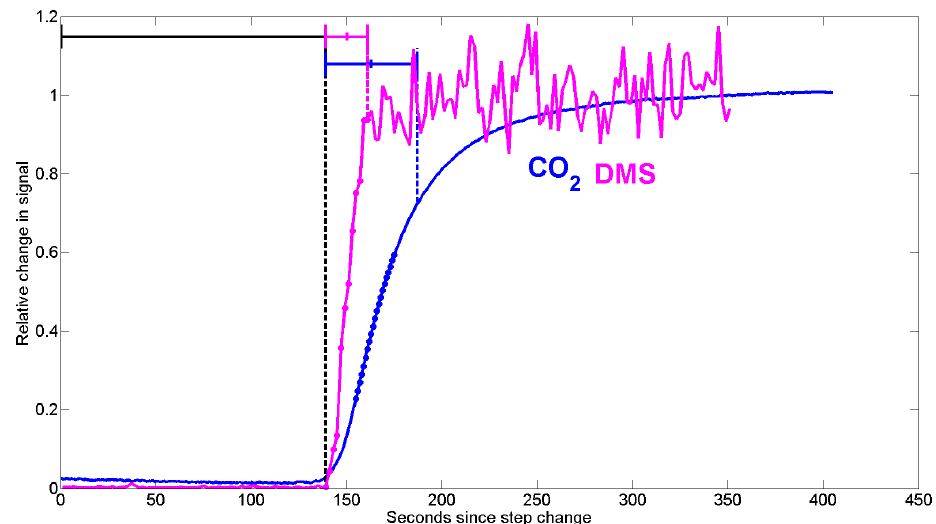
Figure 4. Instrument responses to step changes in seawater CO 2 (blue) and DMS (magenta). Step changes from 350 to 400µatm for CO 2 and 0 to 2nmolL − 1 for DMS have been scaled down so that the initial and end concentrations are between 0 and 1. Time is referenced against the point when the step change was initiated. The response is seen in both instruments after a delay of 138s (black dashed line). Two e -foldings are indicated by vertical dashed lines for CO 2 (blue) and DMS (magenta). The data points marked by circles were used to make an exponential fit to the data to determine the response time (Sect.